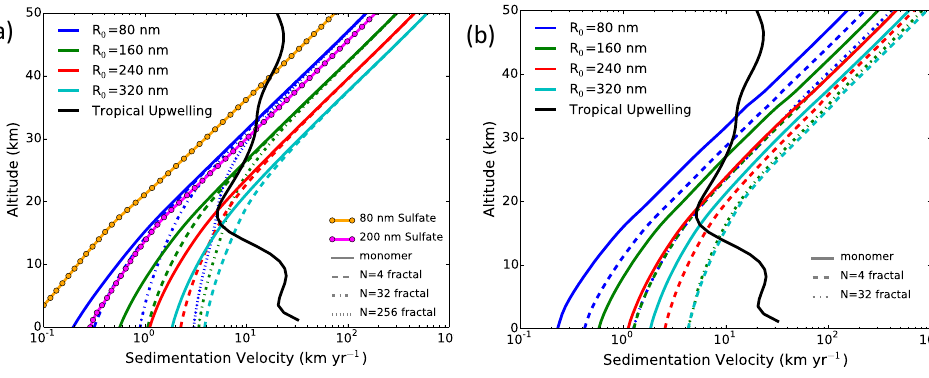
Figure 1. Annual average sedimentation velocity (kmyr − 1 ) versus altitude for (a) uncoated alumina particles and pure sulfate particles and (b) sulfate-coated aged alumina paticles with compact fractal structures averaged over the region from 20 ◦ S to 20 ◦ N latitude. Solid colored lines represent monomers, dashed lines depict fractals with N = 4, dash–dot lines depict fractals with N = 32, and dotted lines depict fractals with N = 256 (for R 0 = 80nm only). Fractal dimension D f = 1.6 for uncoated particles represented in panel (a) , D f = 2.8 for coated and compacted particles shown in panel (b) . The black lines represent the annual average upwelling velocity of the model’s advective transport averaged over the region from 20 ◦ S to 20 ◦ N latitude for